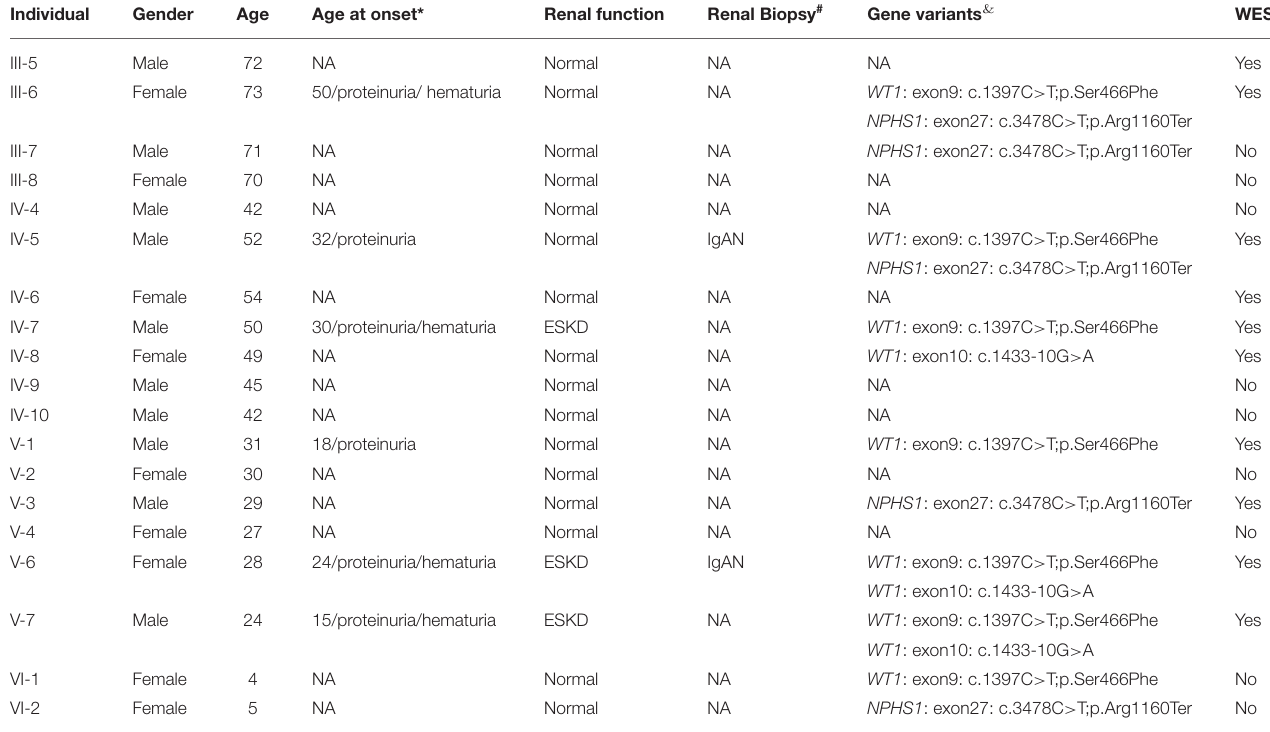
TABLE 1 | Overview of genotypic and phenotypic data of related members in this pedigree. Individual Renal function Renal Biopsy # Gene variants & WES